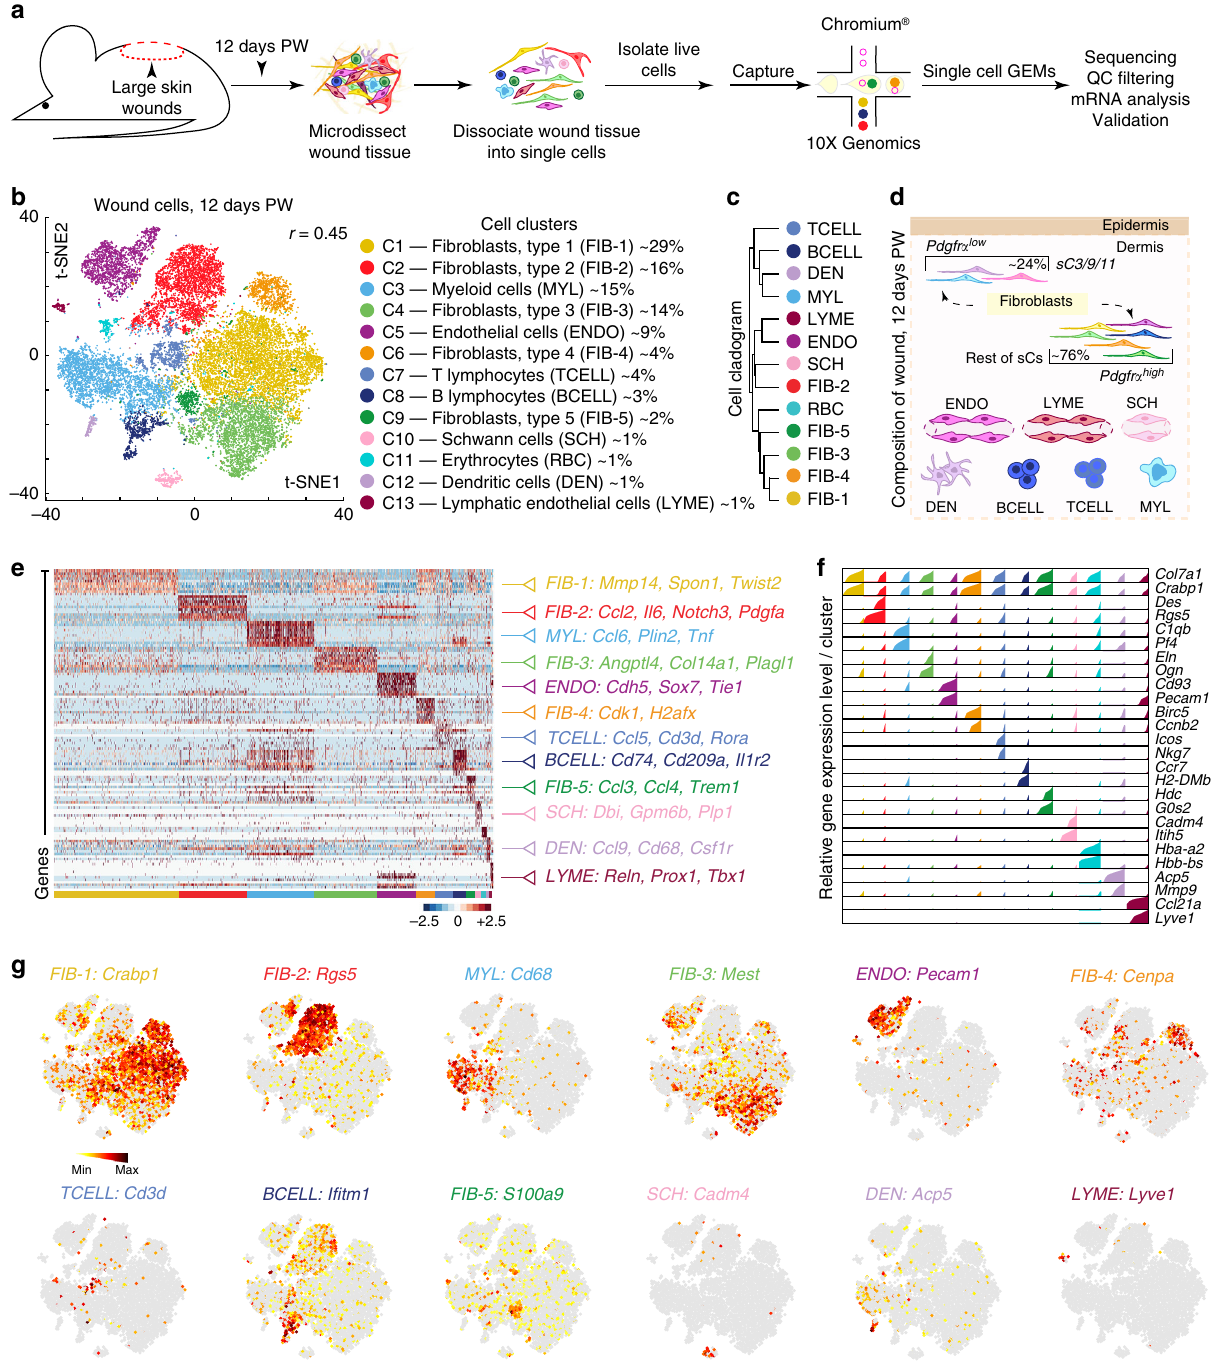
Fig. 1 scRNA-seq analysis reveals cellular heterogeneity in day 12 wounds. a Schematic of cell isolation, cell processing, capture by droplet-based device, sequencing, and downstream analysis. b t-SNE plot revealed cellular heterogeneity with 13 distinct clusters of cells identi fi ed and color-coded. General identity of each cell cluster is de fi ned on the right. Parameter r refers to Seurat ’ s FindClusters function and determined clustering resolution. c Unsupervised hierarchical clustering of average gene signatures showing relatedness of cell clusters (correlation distance metric, average linkage). d Wound schematic showing cellular repertoire. Different cell types, as identi fi ed on scRNA-seq, are color-coded to match colors on b . e Heatmap of differentially expressed genes. For each cluster the top 10 genes and their relative expression levels in all sequenced wound cells are shown. Selected genes for each cluster are color-coded and shown on the right. f Relative expression of selected cluster-speci fi c genes shown as high-density bar charts. Bar height corresponds to gene ’ s relative expression level in each cell and ordering is performed from low to high expressing cells. Two genes are shown per cluster and clusters are color-coded to match the colors in b . g Feature plots of expression distribution for selected cluster-speci fi c genes. Expression levels for each cell are color-coded and overlaid onto t-SNE plot. Cells with the highest expression level are colored black. PW: post-wounding, GEM: gel bead-in-emulsion, QC: quality